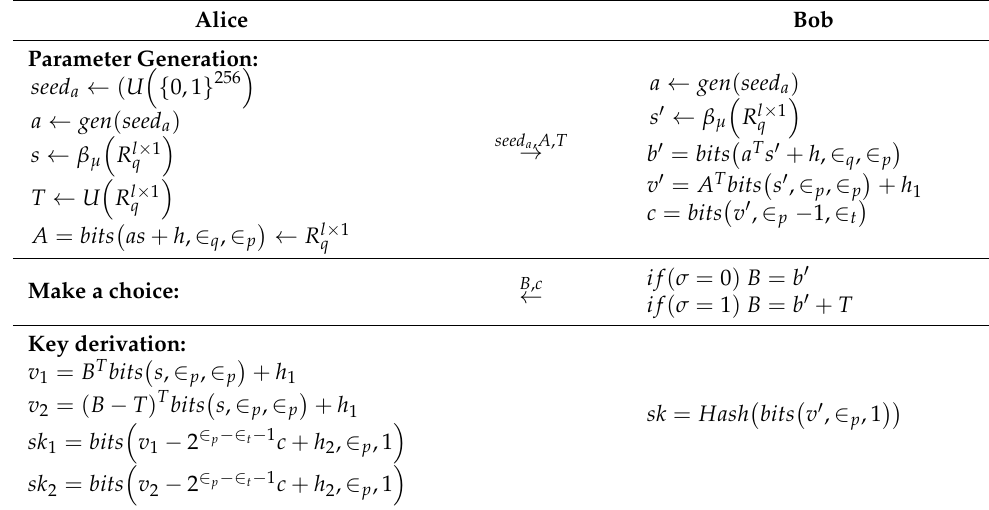
Table 2. Random oblivious transfer